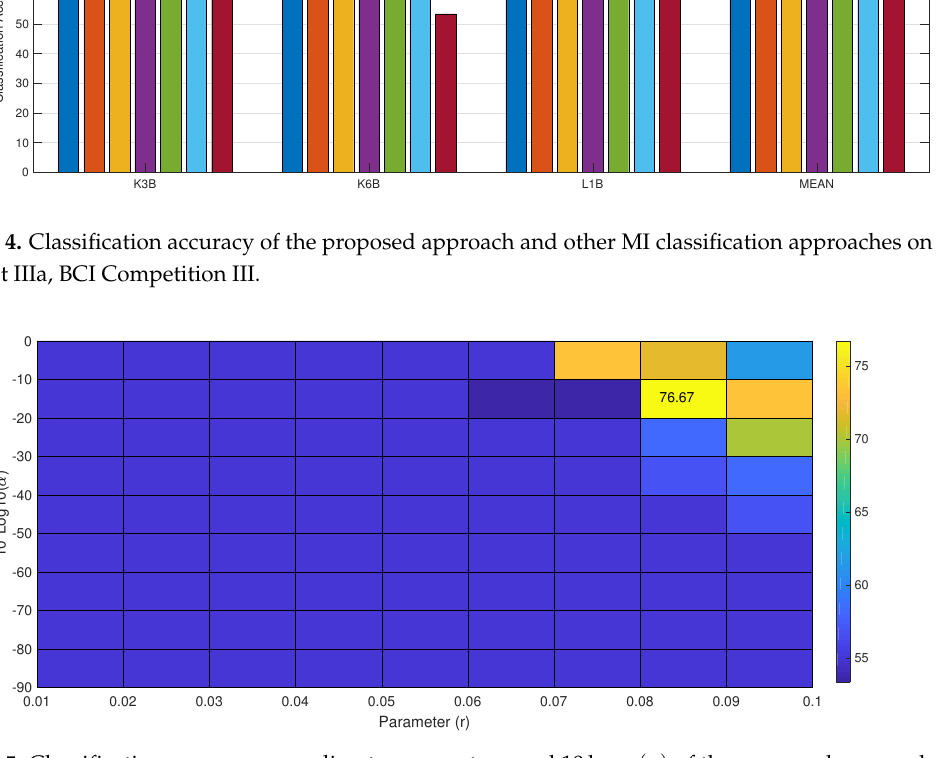
Figure 5. Classification accuracy according to parameter r and 10log on subject K 6 B from Dataset IIIa, BCI Competition